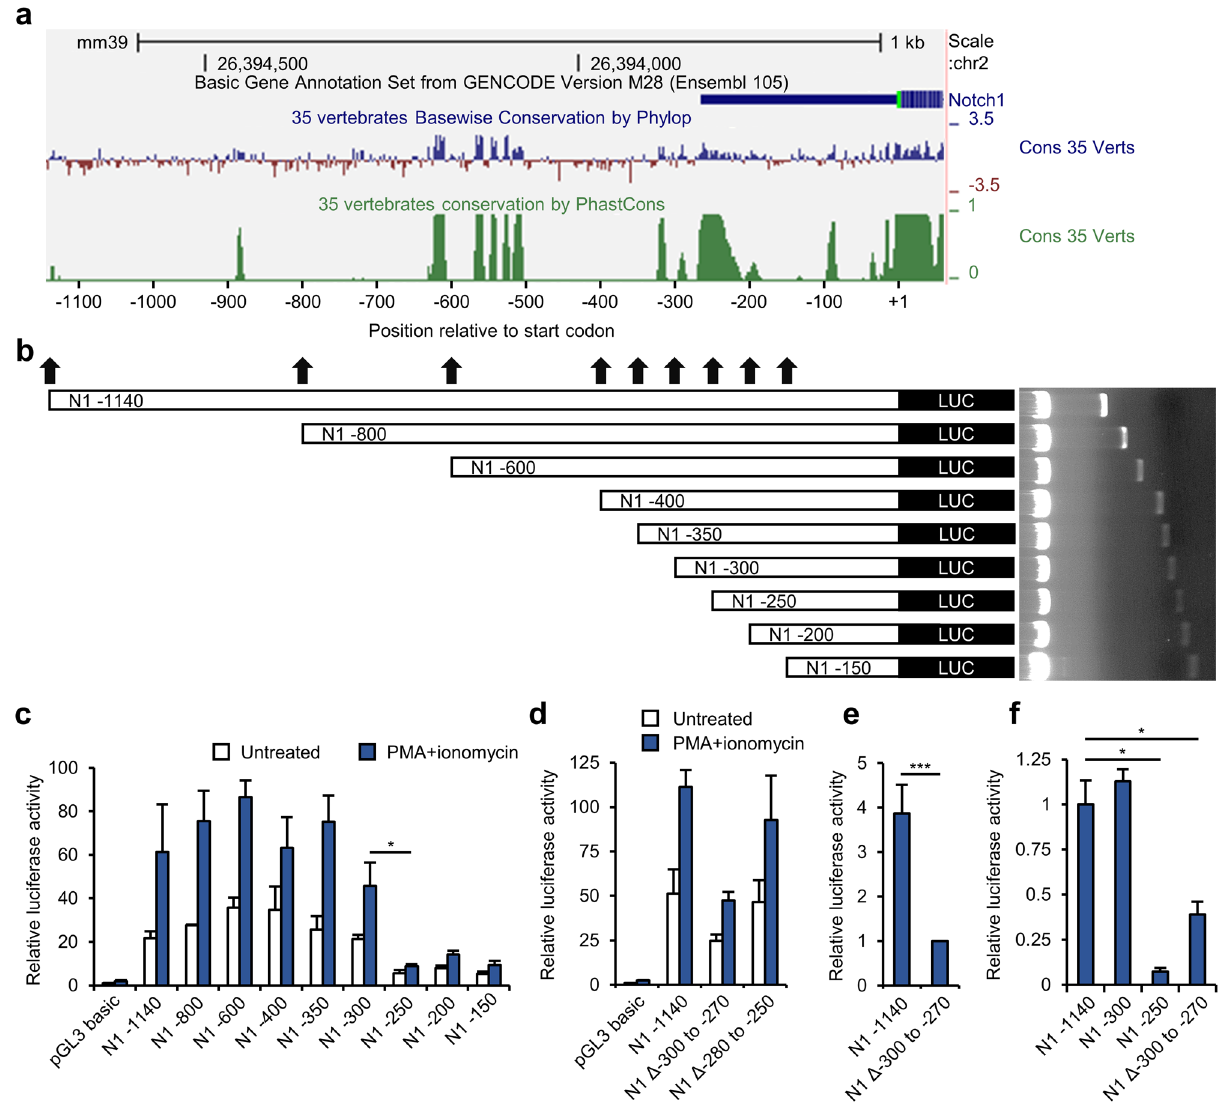
vector constructs. ( c–e ) Luciferase reporter assays performed in activated Jurkat T cells for identification of the key regulatory region using ( c ) transfection with truncated Notch1 promoter reporter vectors, ( d ) transfection with internally deleted Notch1 promoter reporter vectors, and ( e ) activation with anti-CD3 and anti-CD28 antibodies. ( f ) Luciferase reporter assay performed in activated CD4 + T cells transfected with Notch1 promoter reporter vectors selected during steps c–e . Data are mean ± SD. * P ≤ 0.05, ** P ≤ 0.01, and *** P ≤ 0.001 (Student’s t